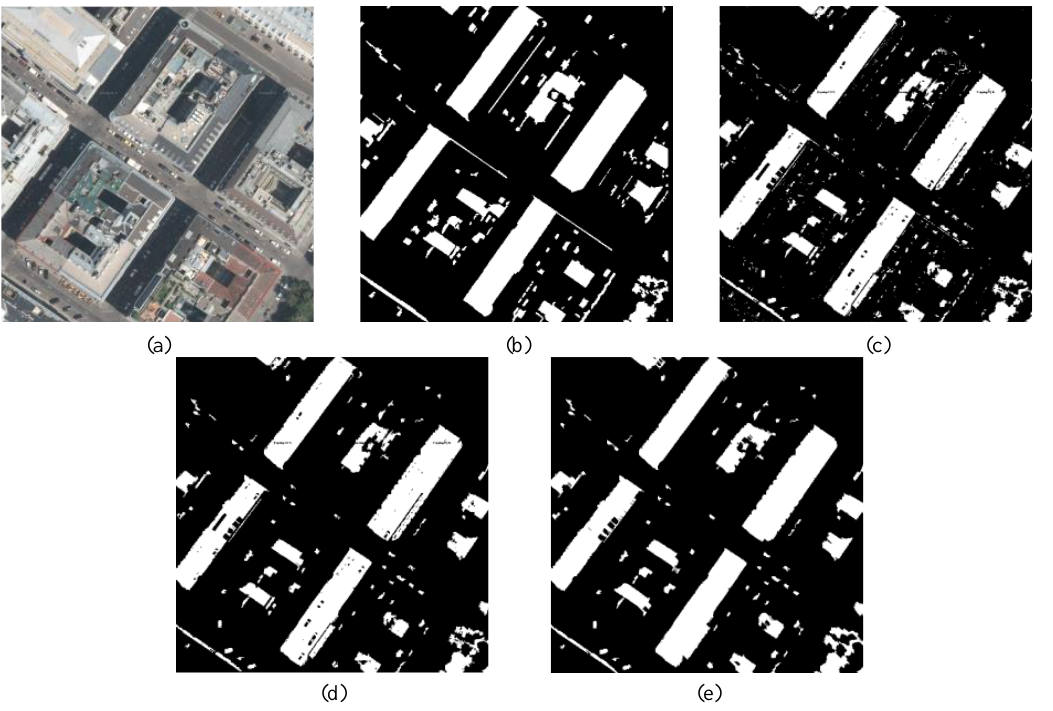
Figure 3. ( a ) Original image; ( b ) ground truth; ( c ) initial detection chart; ( d ) small-area-removal diagram; ( e ) mathematical morphology closed-operation diagram.